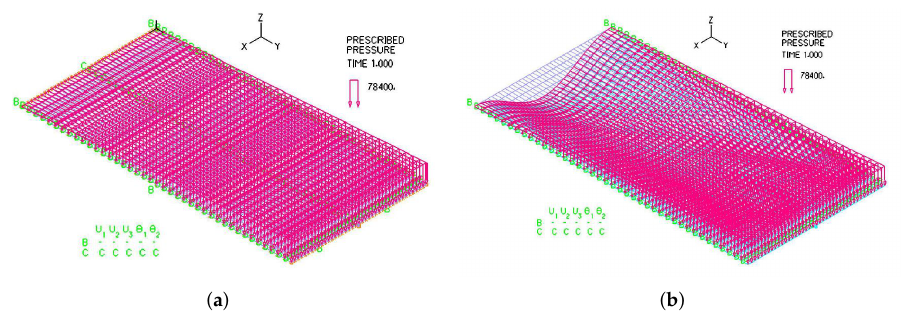
Figure 5. A typical two-dimensional plate and beam ADINA model with master and slave nodes. ( a ) Plate and beam model, ( b )